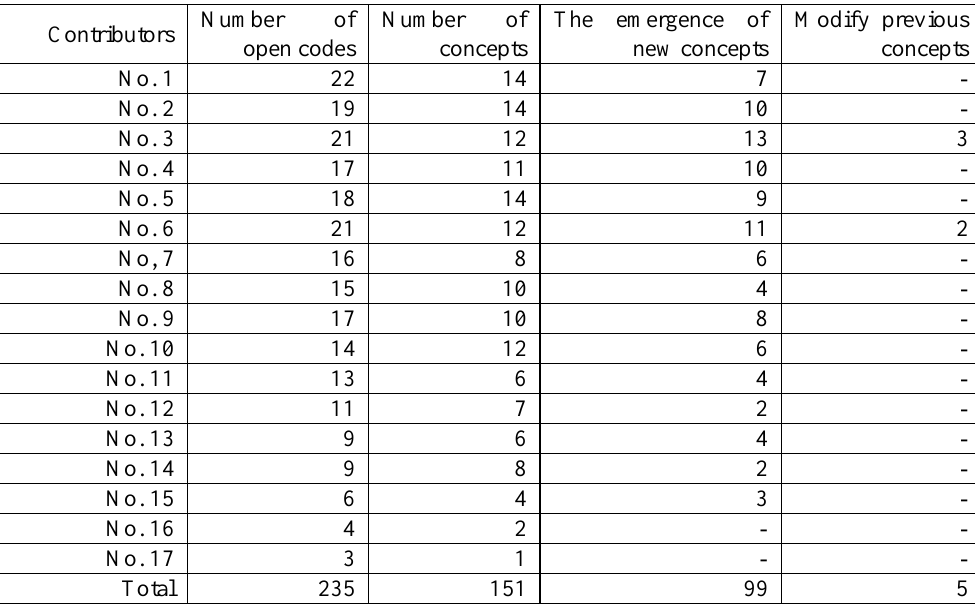
Table 3. The process of the emergence of concepts and categories up to the limit of theoretical adequacy Number of Contributors open